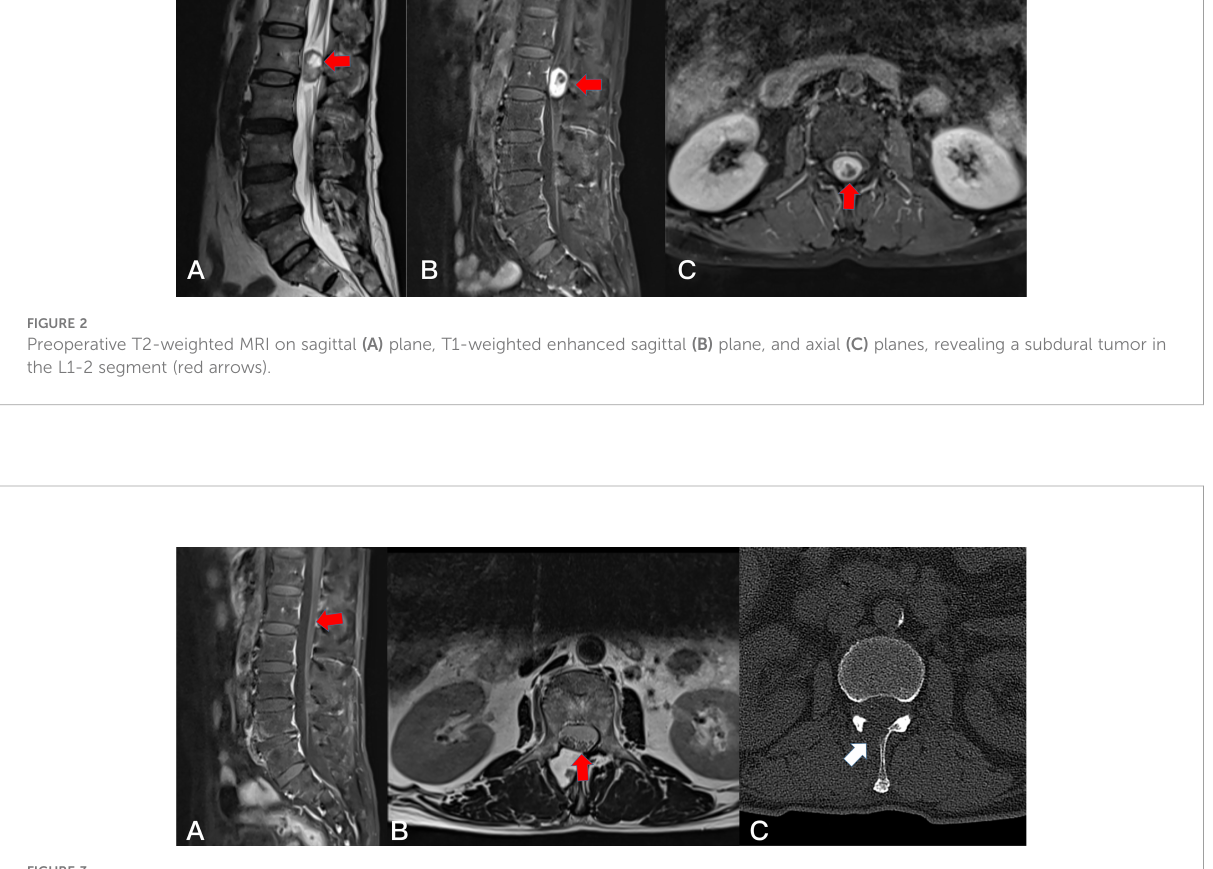
FIGURE 3 Postoperative T1-weighted enhanced MRI on sagittal (A) planes and T2-weighted MRI on axial (B) . Resection of the subdudral tumor could not be identi fi ed after 1 months (red arrows). The axial plane (C) of CT scan showed the bone window of L1 lamina (white arrows).